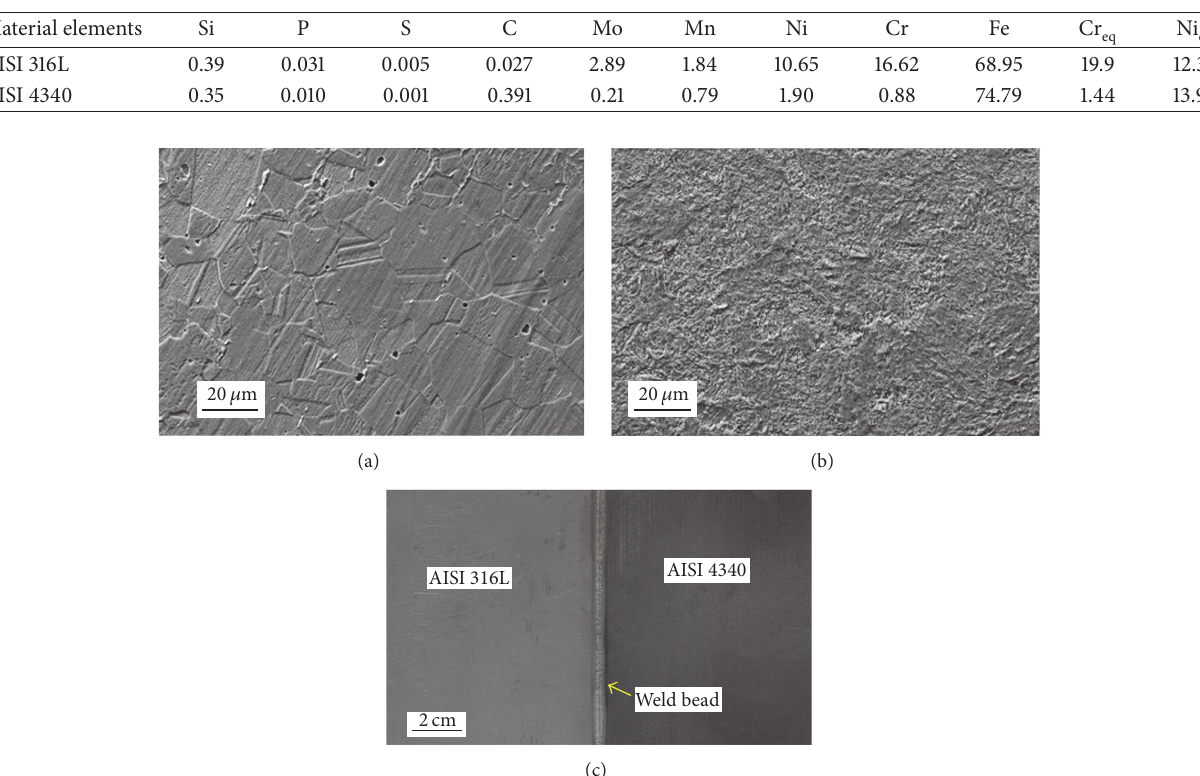
Table 1: The chemical composition of the base metals.